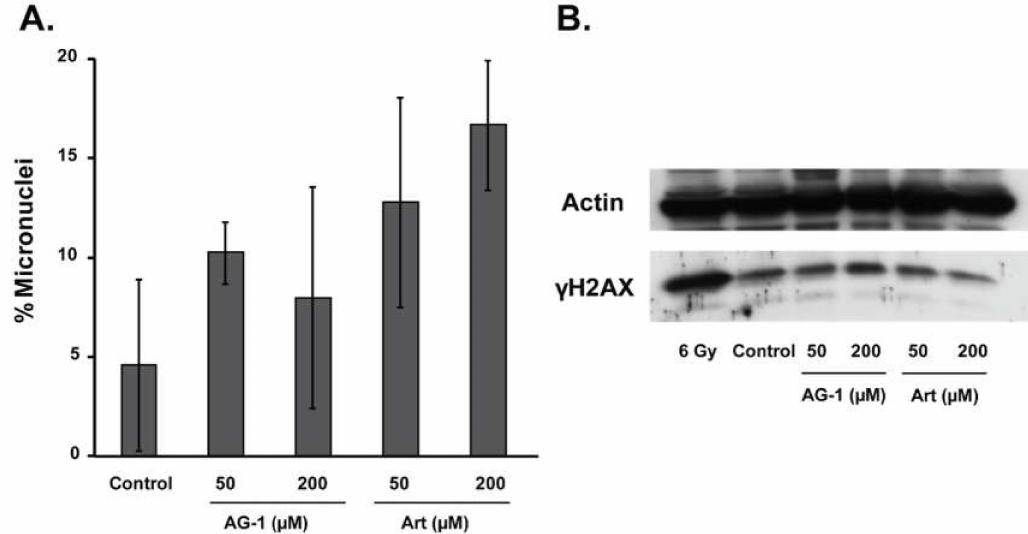
Figure 6. Artemisinin dimer (AG-1)-induced cytotoxicity appears to be independent of DNA damage measured at 72 hours post-treatment. ( A ) AG-1 and Art treatments did not cause any significant change in the percentage of micronuclei. Asynchronous cultures of MB-231 cells were treated for 72 hours with 50–200 µ M of Art or AG-1 and then incubated with cytochalasin-B followed by staining with acridine orange. Micronuclei in binucleated cells with well-preserved cytoplasm were scored using microscopy. ( B ) AG-1 and Art treatments did not cause any significant change in the levels of phosphorylated H2AX ( γ H2AX). Total cellular protein extracts isolated from 72 hours control, Art- and AG-1-treated cells were separated by SDS-PAGE and transferred onto a nitrocellulose membrane. The membrane was then incubated with antibodies to γ H2AX and